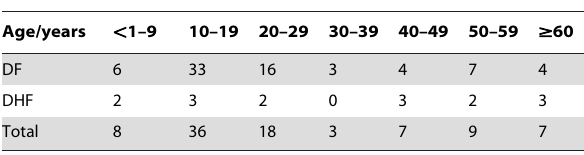
Table 3. Frequency of cases and controls by age-group.